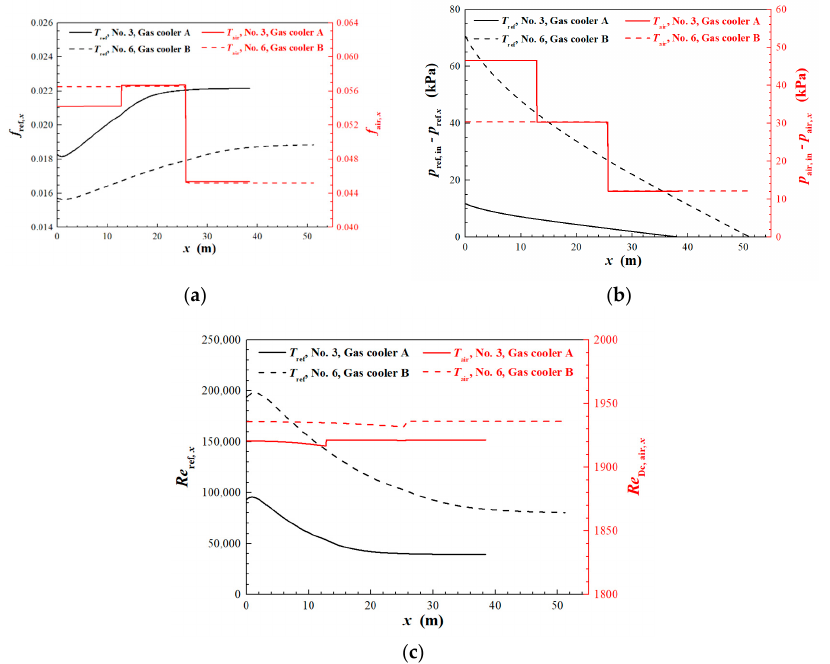
Figure 7. Local hydraulic performance of sCO 2 and air: ( a ) friction factor; ( b ) pressure drop, and ( c ) Reynolds number.